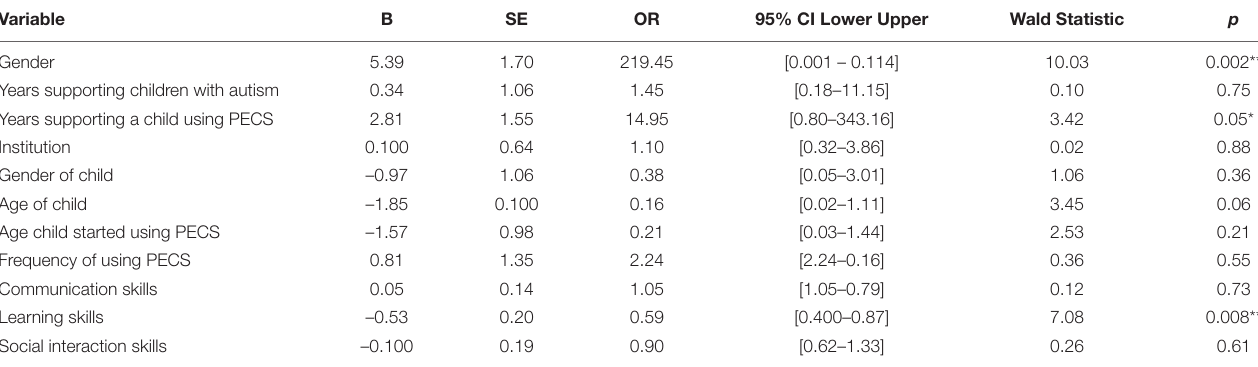
TABLE 3 | Summary of binary logistic